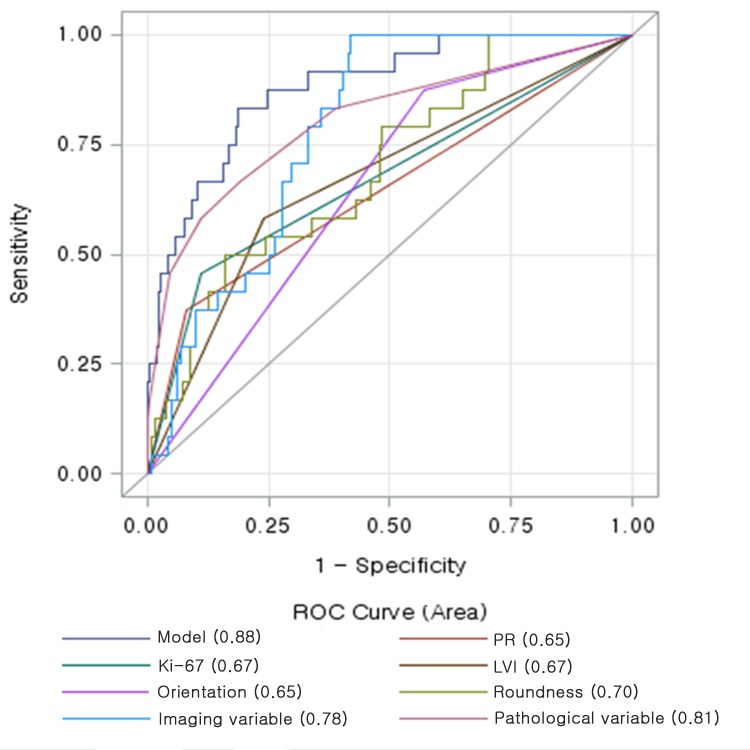
Receiver-operating characteristic curve determined by multivariate logistic regression analysis for distinguishing high recurrence scores from low or intermediate recurrence scores: parallel orientation, tumour roundness, lymphovascular invasion, PR negativity, and high Ki-67 are predictors of recurrence.Data in parentheses indicate the Az values for the each variables.